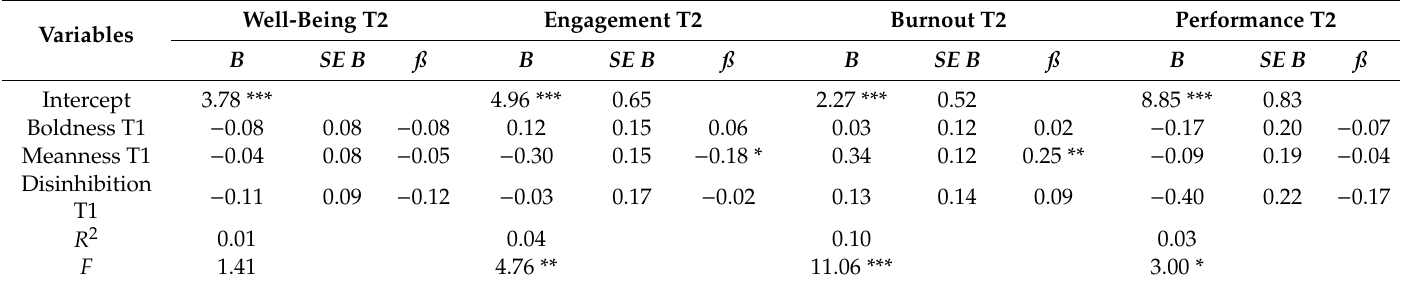
Table 7. Regression analyses of perceived manager psychopathy (Time 1) predicting engagement, burnout and performance in subordinates (Time 2). Well-Being Variables